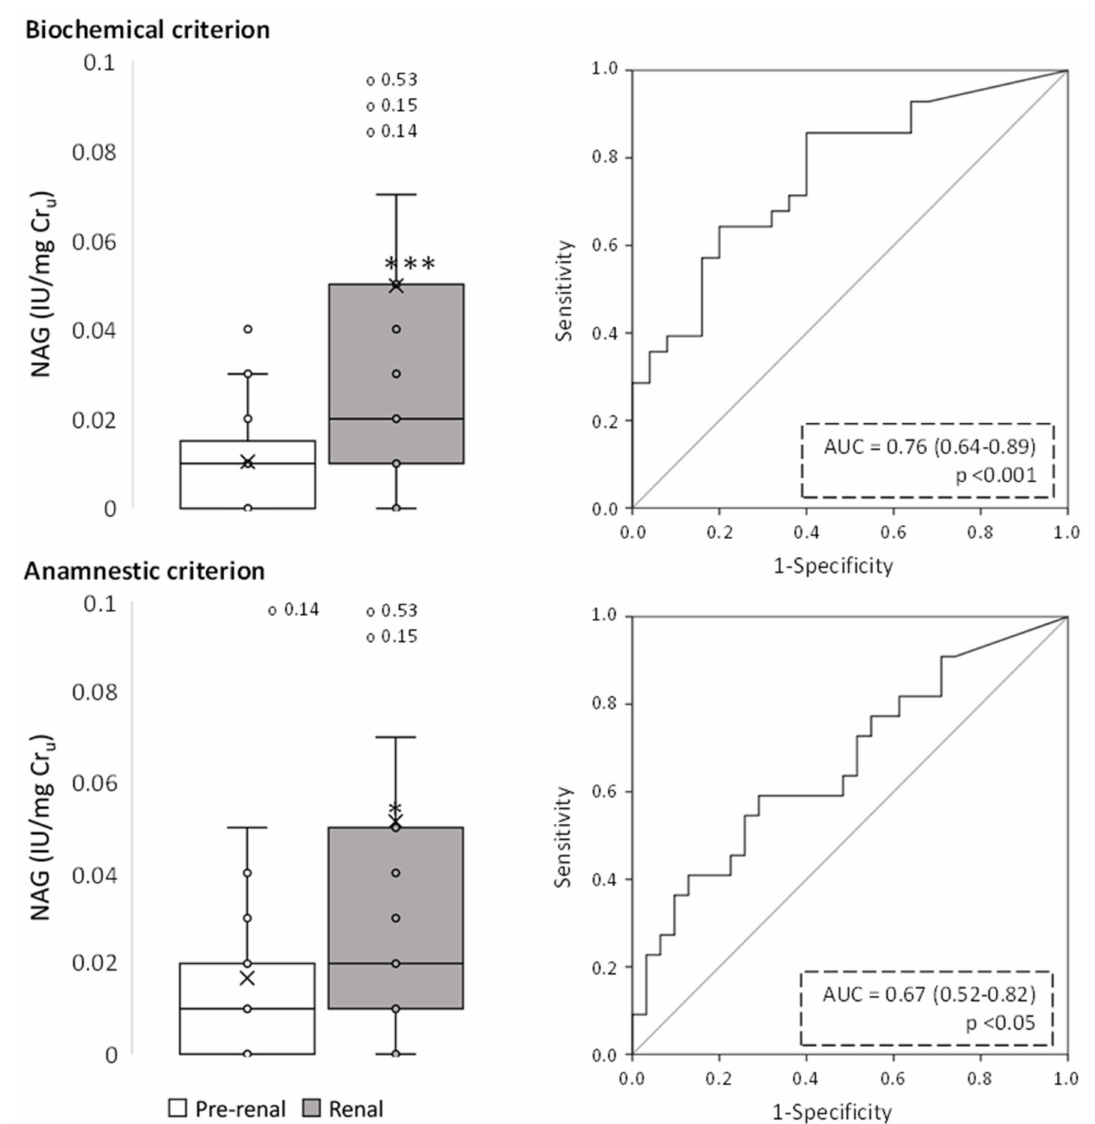
Figure 4. Urinary NAG levels of pre-renal and renal AKI patients following classification by bio- chemical and anamnestic criteria, shown as box plots ( left panels) representing median values in international units (IU) of urinary NAG per mg urinary creatinine (Cr u ), and ROC curves ( right panels). AUC: area under the ROC curve showing the pre-renal/renal classification efficacy of urinary NAG. The × in box plots represents the median value. *, p < 0.05; ***, p <